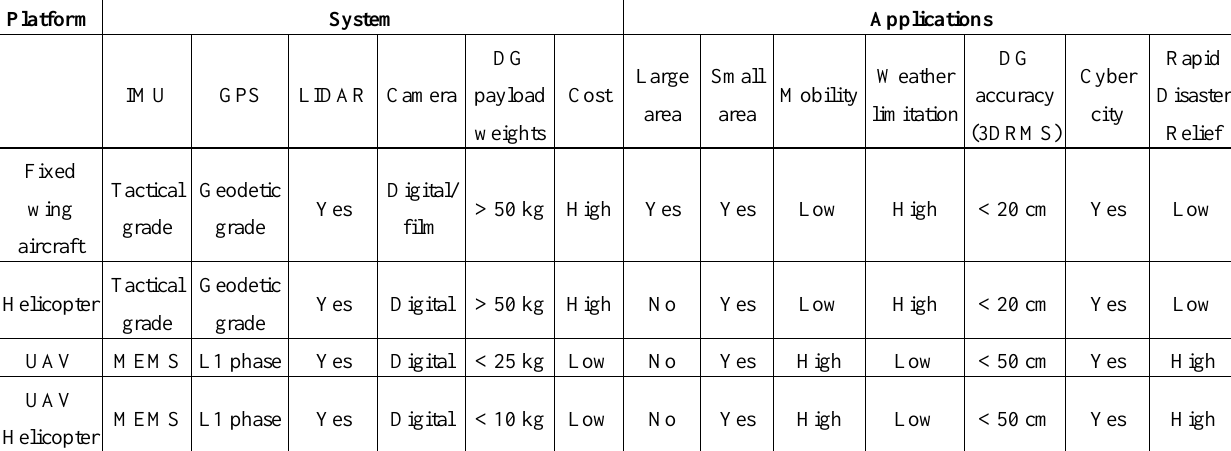
Table 2. Comparison of various airborne photogrammetric platforms (adopted from